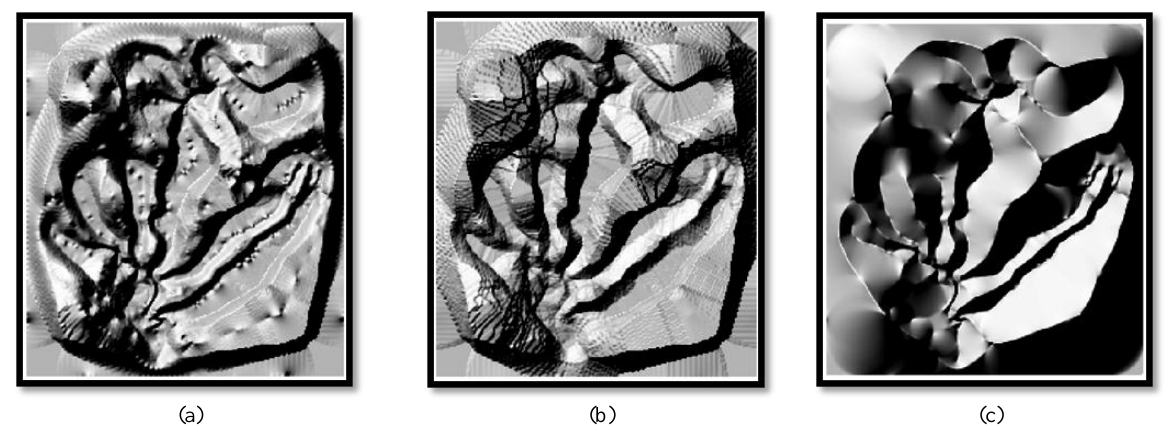
Figure 5. The hillshades of the DEM constructed from (a) IDW, (b) OK, and (c)